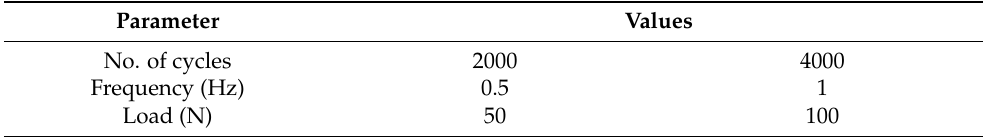
Table 1. Fatigue testing